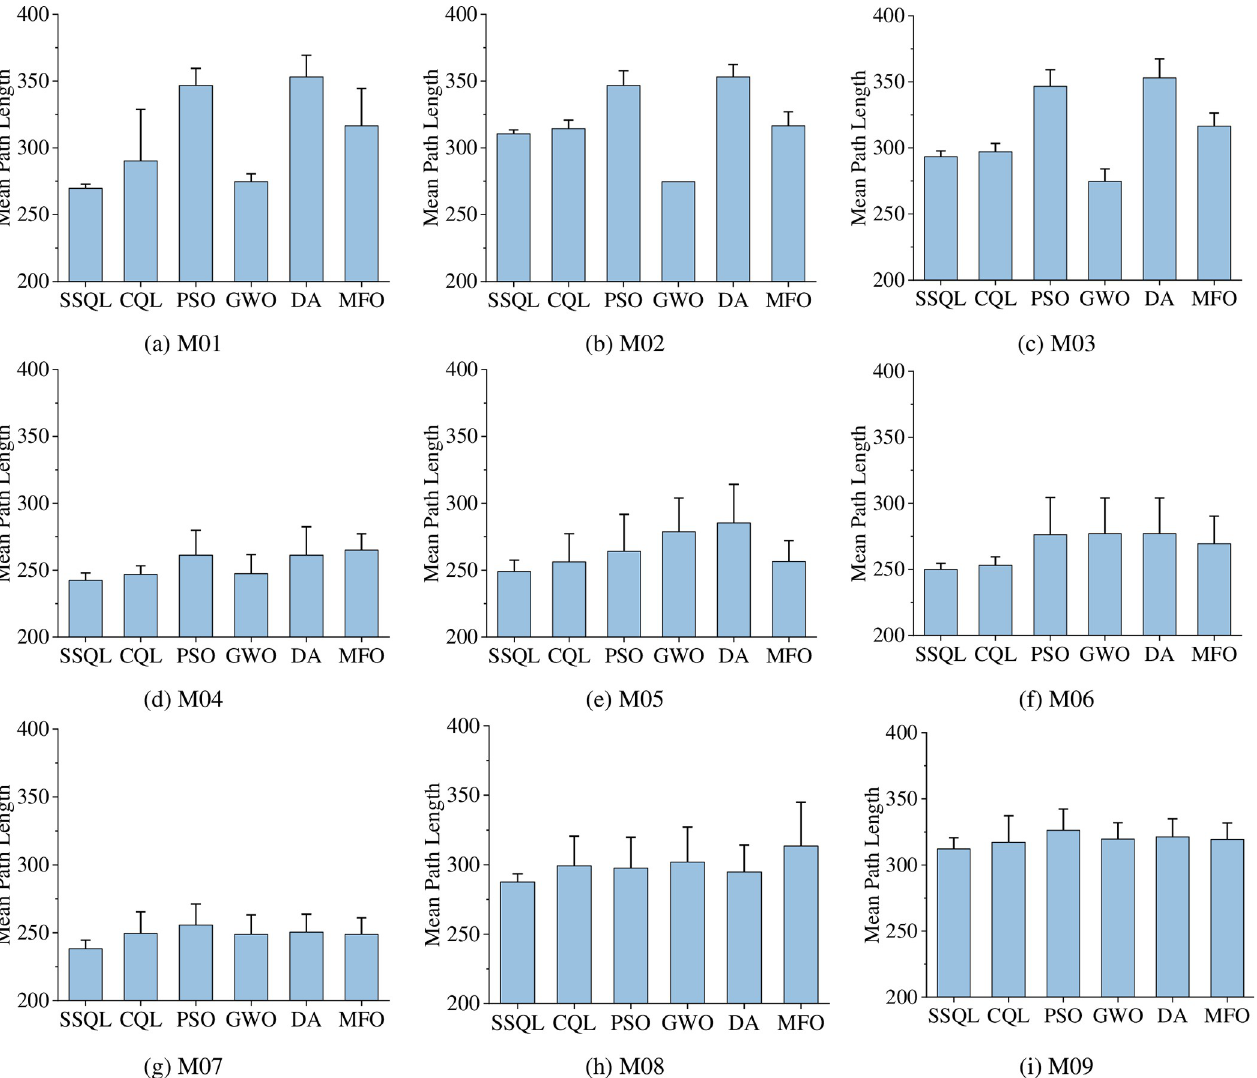
Fig 4. Compared mean path length of various path planning algorithms for MR (The interval on each bar denotes the standard deviation of the path length).